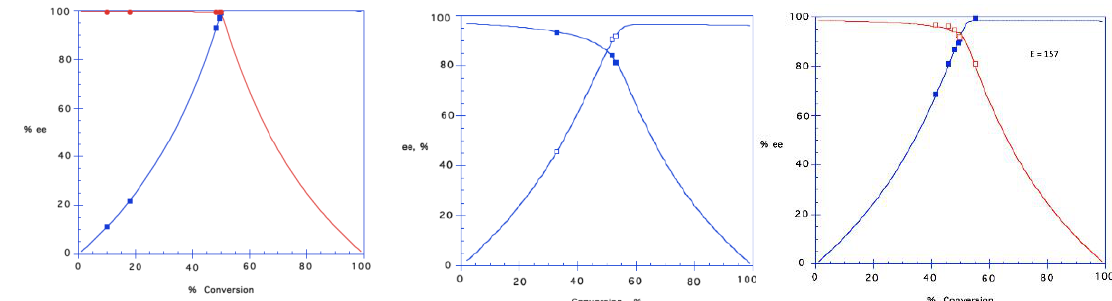
Figure 1. Graphical illustration of reaction progress of kinetic resolution at different degrees of conversion. Left panel : 1a ee p (red filled squares) and ee s (blue filled squares); E -value >200. Middle panel : kinetic resolution of 2a ee p (filled squares) and ee s (open squares) E = 66. Right panel : 3a ee p (open red squares) and ee s (filled blue squares); E = 157. All three reactions used CALB from SyncoZymes as catalyst and vinyl butanoate as acyl donor in different solvents. All reactions were performed at 30 ◦ C. E -values calculated from E&K Calculator 2.1b0 PPC [24].